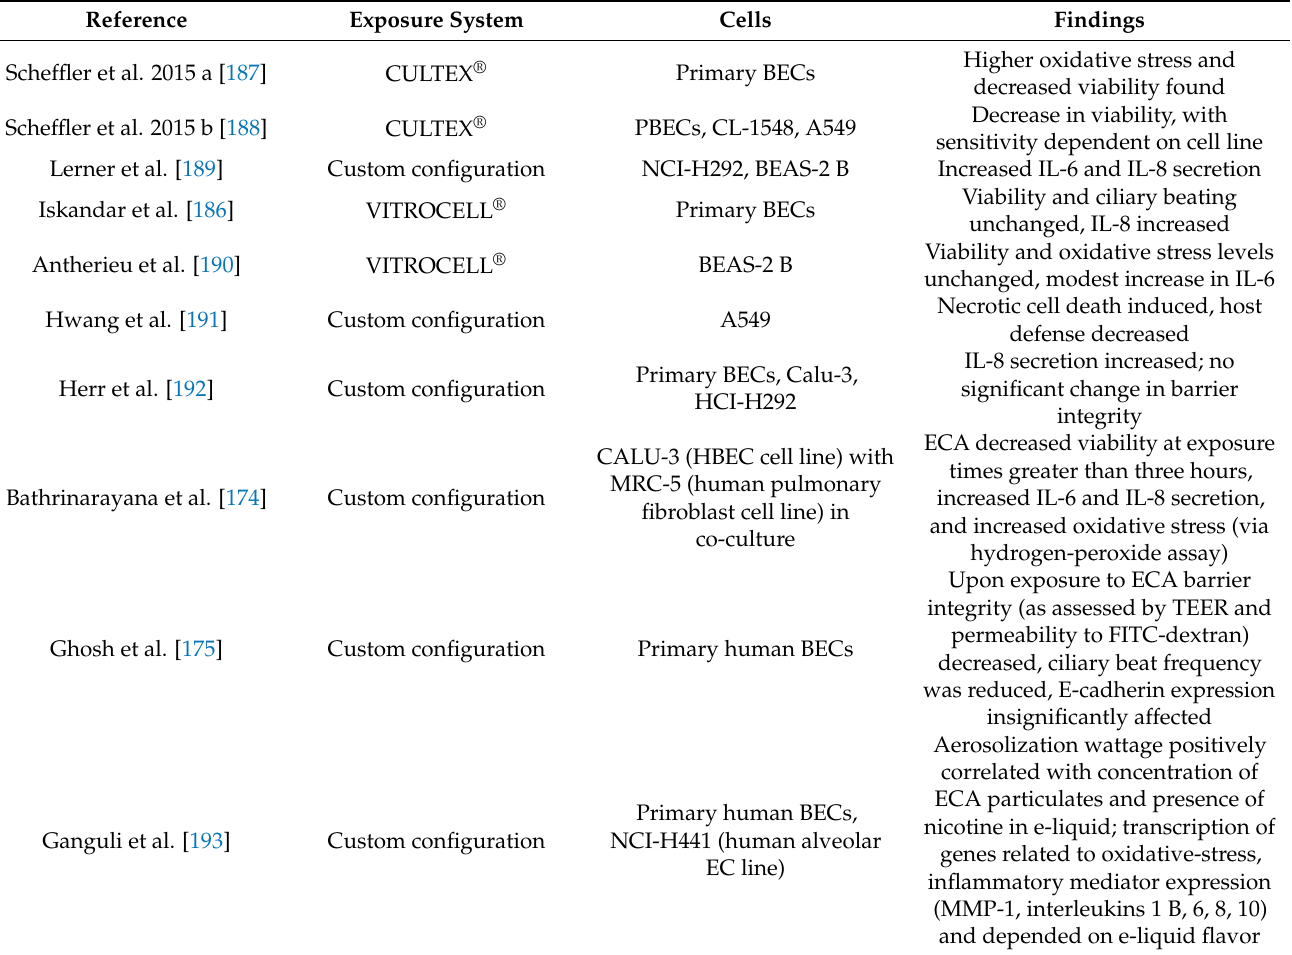
Table 5. Summary of Electronic Cigarette Aerosol Studies at Static Air–Liquid